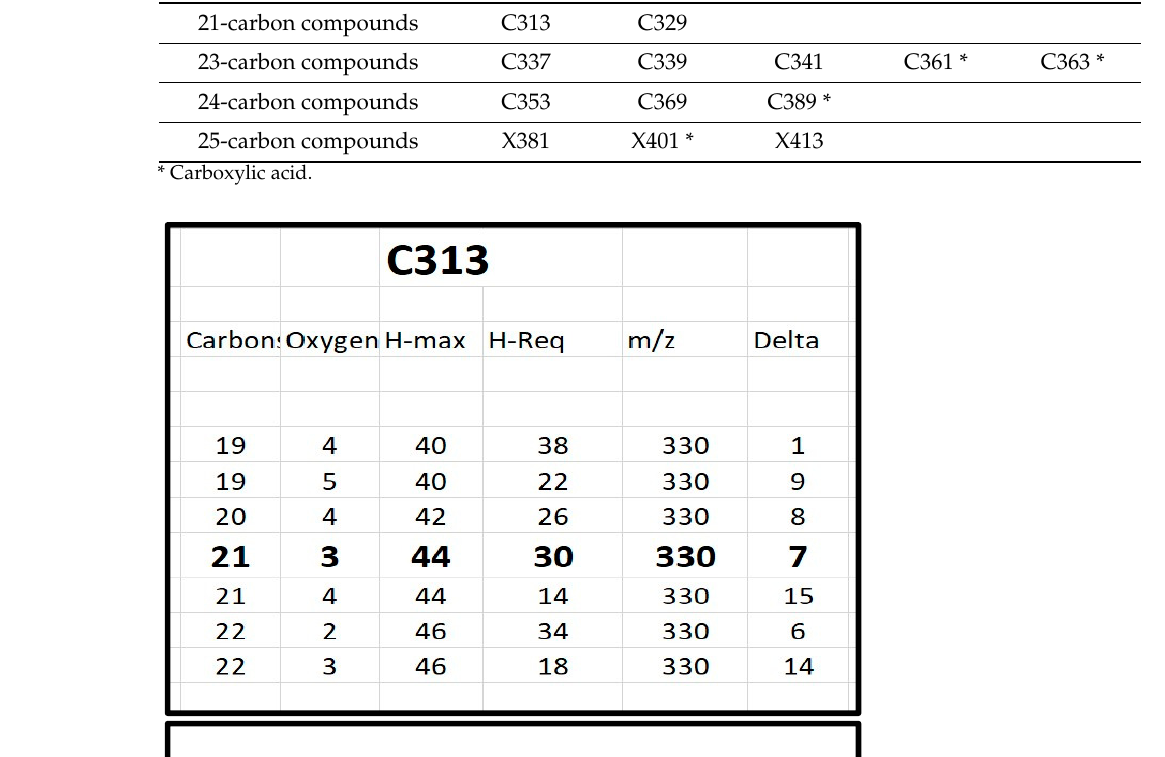
Table A1. List of steroid phosphodiesters identified.